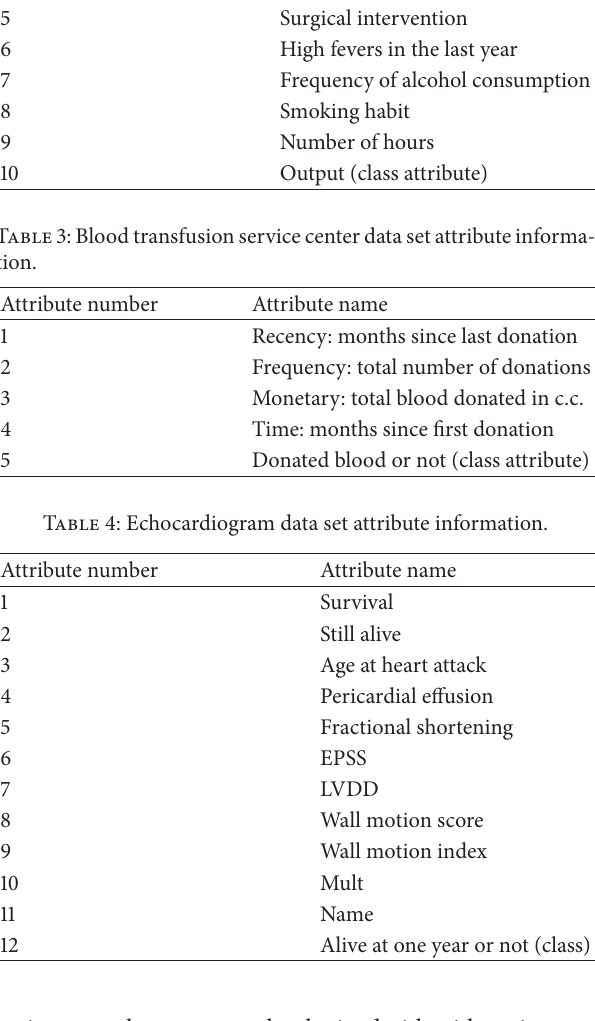
Table 6: Classification results with blood transfusion service center